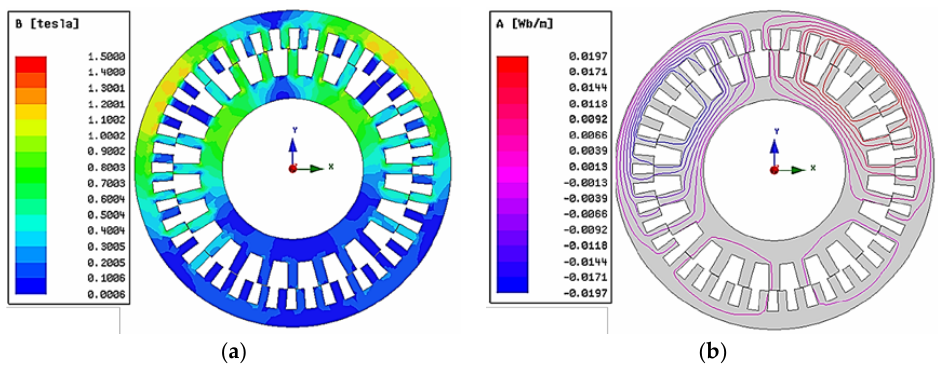
Figure 12. Optimal model ( a ) flux density plot and ( b ) flux lines plot.